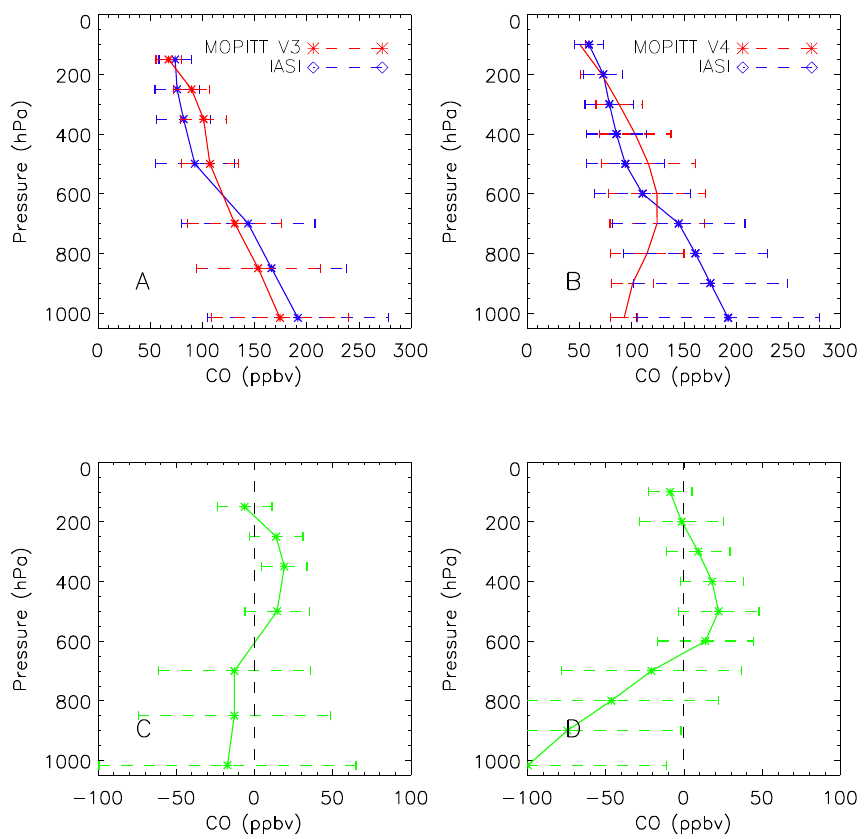
Fig. 7. (A) MOPITT V3 and IASI CO mean profiles (solid red line and blue line, respectively) and standard deviation relative to their means (dashed lines), (B) MOPITT V4 and IASI CO mean profiles (solid red line and blue line, respectively) and standard deviation relative to their means (dashed lines), (C) the mean difference between MOPITT V3 CO and IASI CO (solid green line) and the standard deviation (dashed green line) relative to the mean, and (D) the mean difference between MOPITT V4 CO and IASI CO (solid green line) and the standard deviation (dashed green line) relative to the mean. The IASI CO retrievals closest to the MOPITT pressure levels are used here, and all comparisons are for over the ocean and during the daytime of 1 September 2007, over the Southern Africa region.